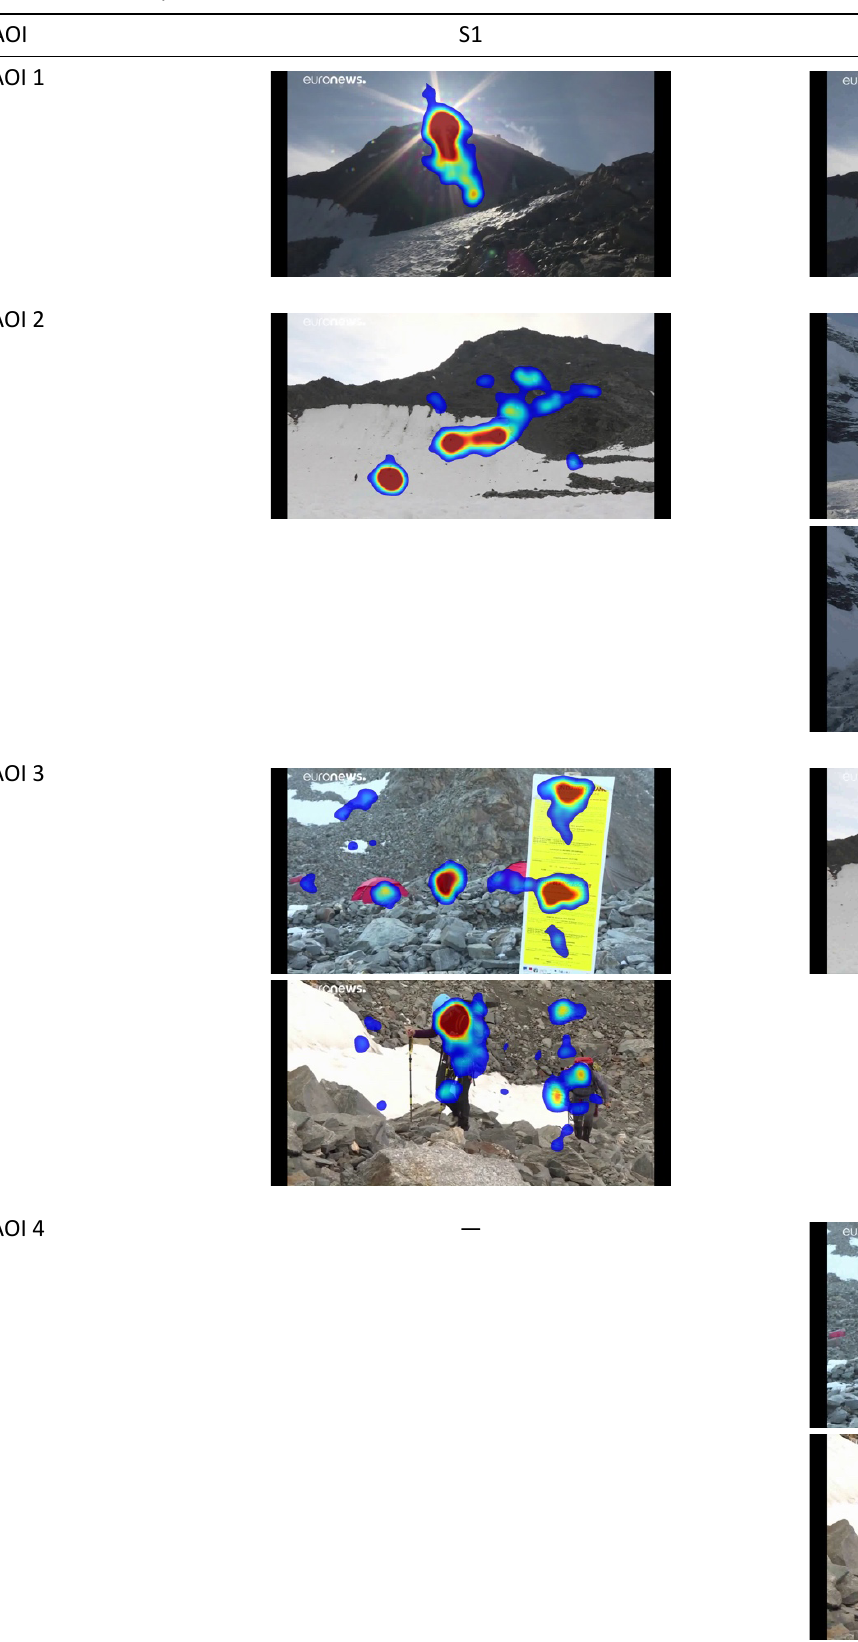
Table 3. Heat maps of the